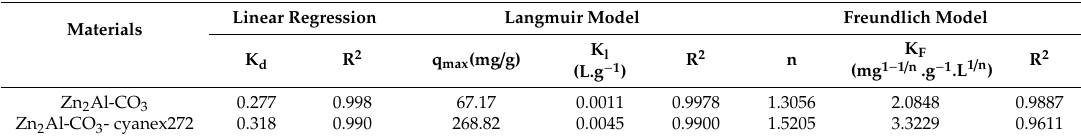
Table 3. Langmuir and Freundlich constants and correlation coe ffi